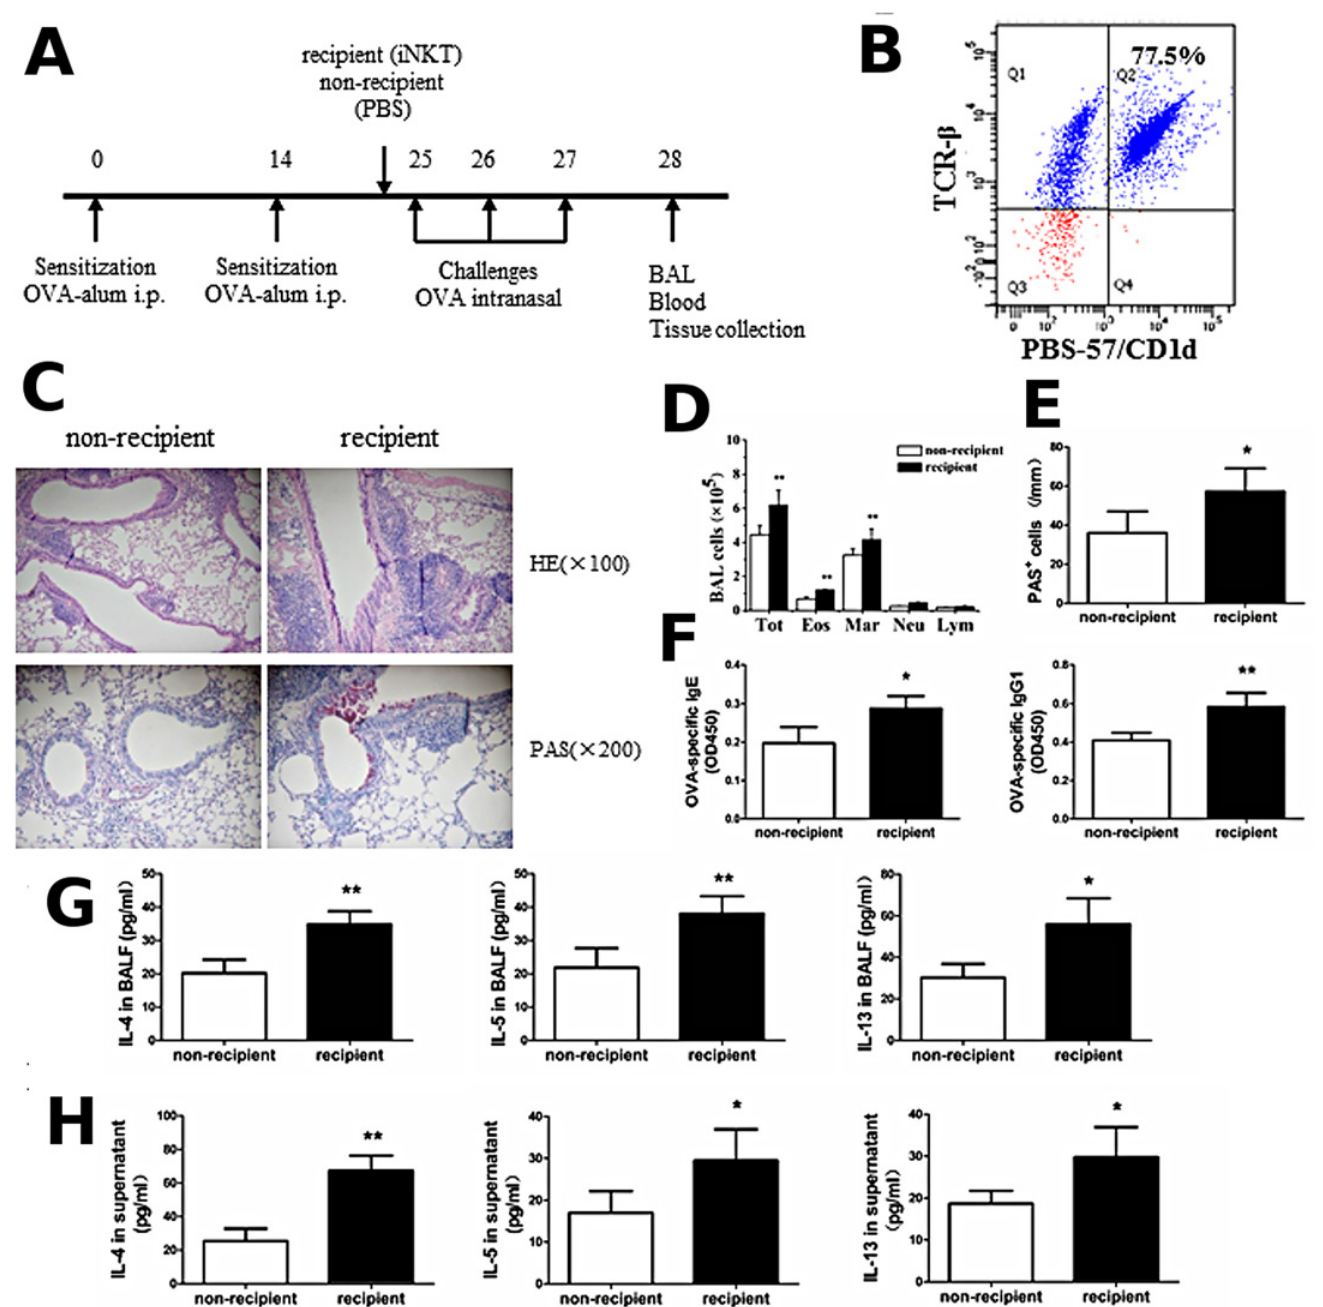
Fig 6. Adoptive transfer of iNKT cells enhances the Th2 inflammatory response in OVA-induced asthma model. A . Timeline of the OVA immunization/challenge protocol and the names of the treatment groups (PBS or iNKT cells). B . Purity of the adoptively transferred iNKT cell population. Flow cytometry shows 77.5% of the adoptively transferred cells stained with both PBS-57/CD1d tetramers and monoclonal antibody against TCR- β . C . Histopathological analysis using hematoxylin-eosin (H&E) staining and periodic acid-Schiff (PAS) staining of the lung tissue sections from OVA-induced asthmatic mice treated with adoptive transfer of iNKT cells or PBS. D . Total cell and differential cell counts in the BALF from OVA-induced asthmatic mice treated with adoptive transfer of iNKT cells or PBS were obtained by a standard hemocytometer. N = 4 per group and ** P < 0.01. Tot, total cell counts; Mar, macrophages; Eos, eosinophils; Neu, neutrophils; and Lym, lymphocytes. E . Lung goblet cell hyperplasia is expressed as the number of PAS-positive cells per unit of length (mm) of the basement membrane. N = 4 per group and * P < 0.05. F . OVA-specific Ig levels from OVA-induced asthmatic mice treated with adoptive transfer of iNKT cells or PBS were analyzed by ELISA. N = 4 per group and * P < 0.05, ** P < 0.01. G . BALF were collected 24 h after the final challenge and cytokine (IL-4, IL-5, and IL-13) production from OVA-induced asthmatic mice treated with adoptive transfer of iNKT cells or PBS was analyzed